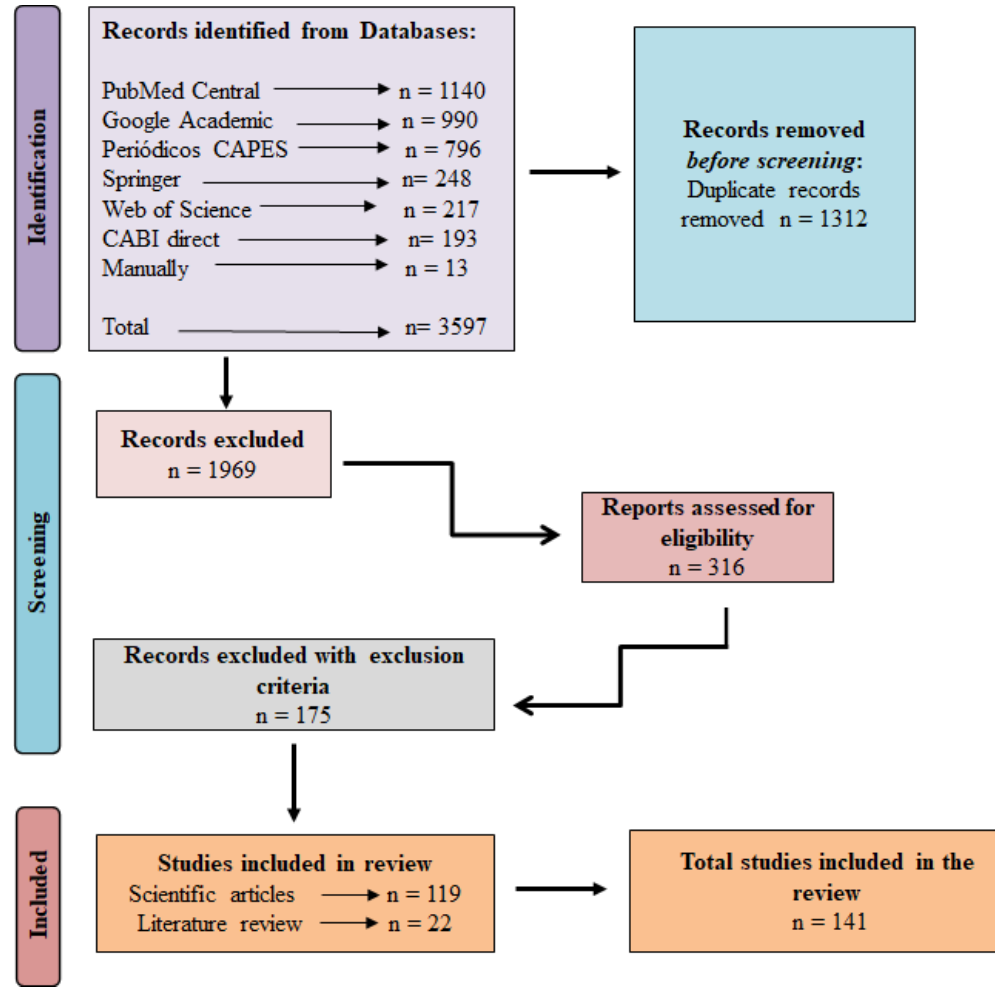
Figure 1 . PRISMA flow diagram of the studies included in the systematic review of CRISPR/Cas technology used to edit genes for tolerance to abiotic stresses in plants.